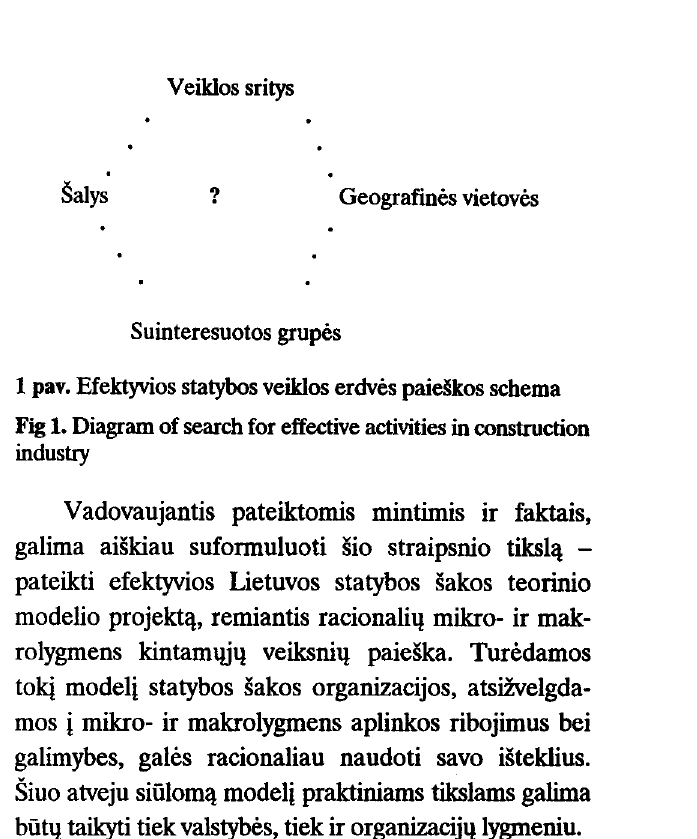
Fig 1. Diagram of search for effective activities in construction